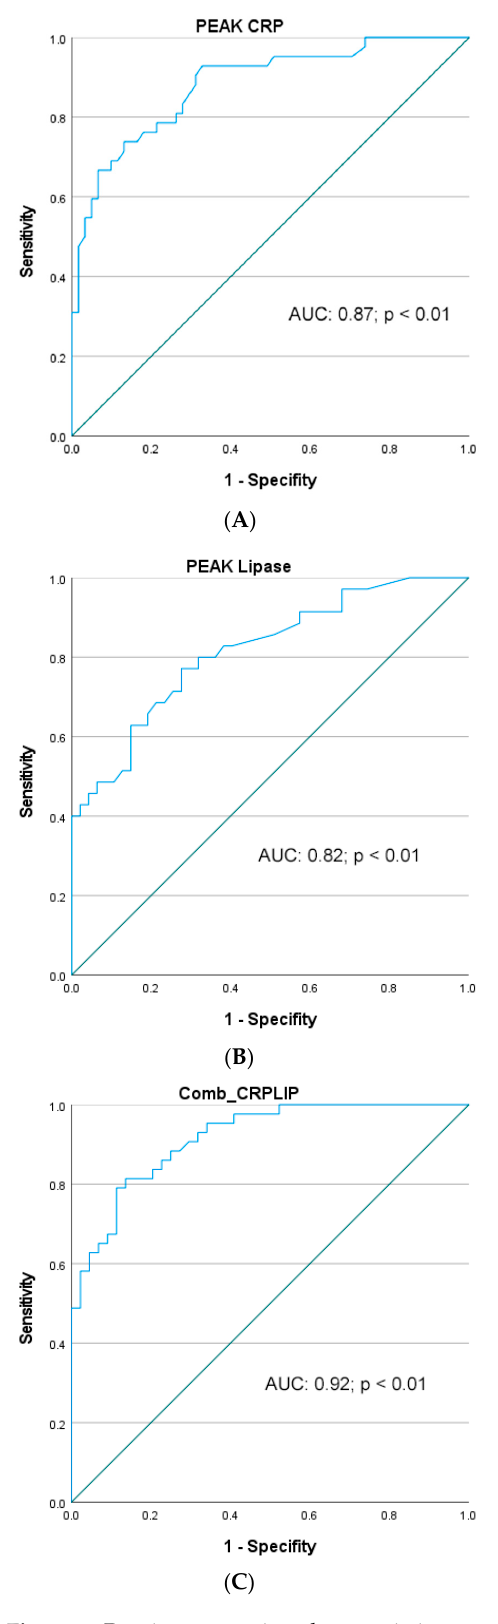
Figure 2. Receiver operating characteristic curve for ( A ) peak CRP value, ( B ) peak lipase value as well as ( C ) combination peak CRP and lipase (Comb_CRPLIP) as predictors for early pancreatic graft dysfunction following SPKT.